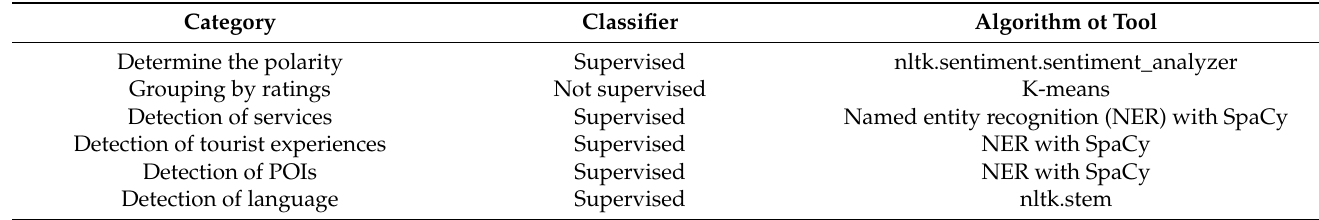
Table 8. Tourist review